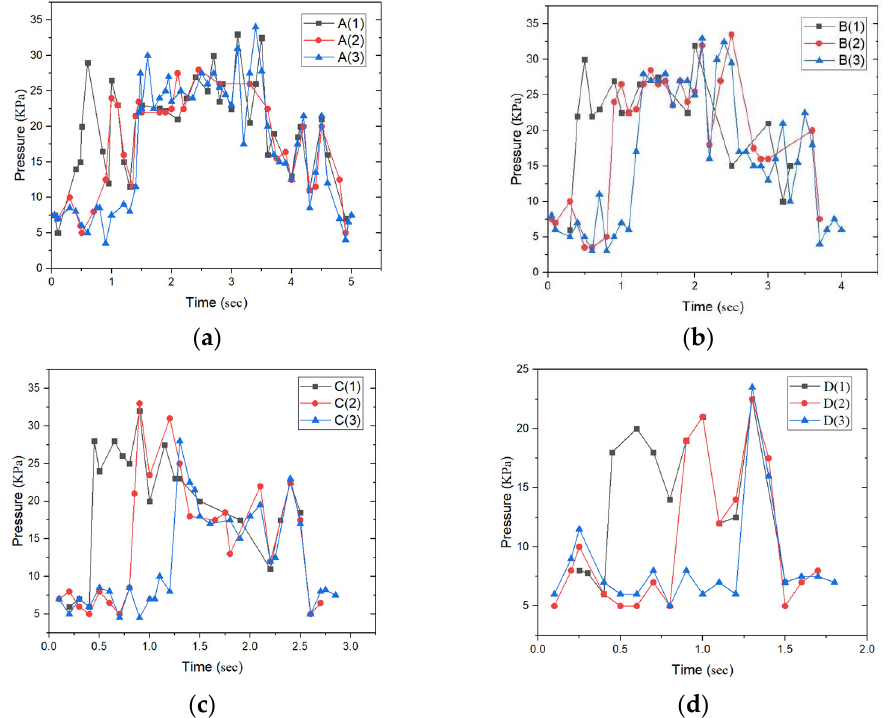
Figure 28 . Pressure of the di ff erent numbers of cups at the A, B, C and D monitoring points: ( a ) Figure 28. Pressure of the different numbers of cups at the A, B, C and D monitoring points: ( a ) Point